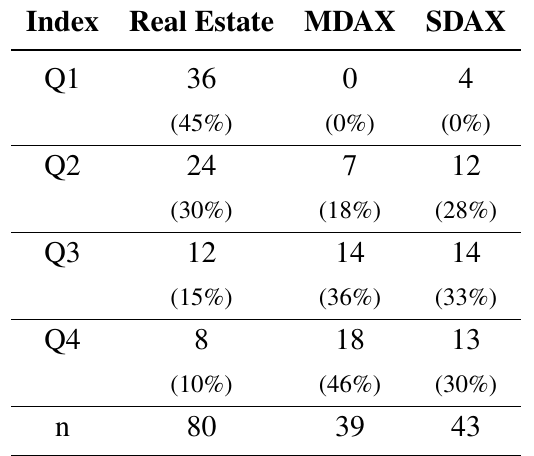
Table 6. Quartile distribution of real estate, MDAX and